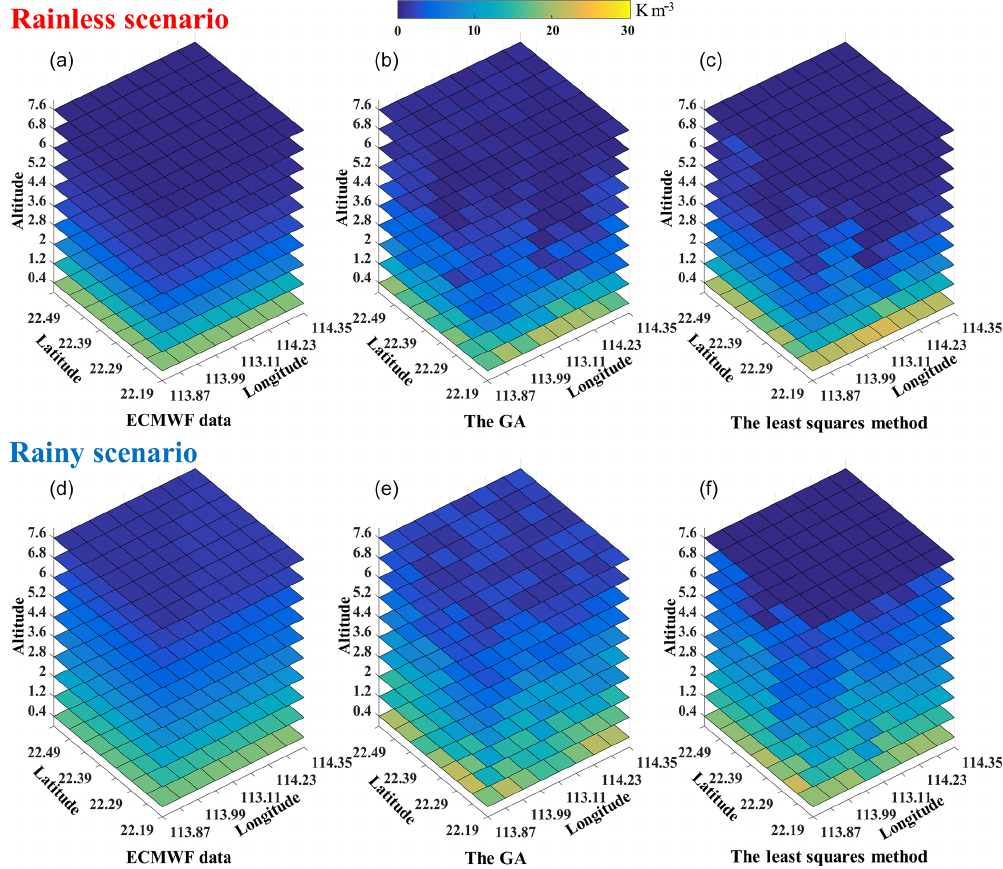
Figure 12. The three-dimensional distribution of water vapour density derived from ECMWF data, the GA method and the least squares method (upper for rainless scenario and lower for rainy scenario).